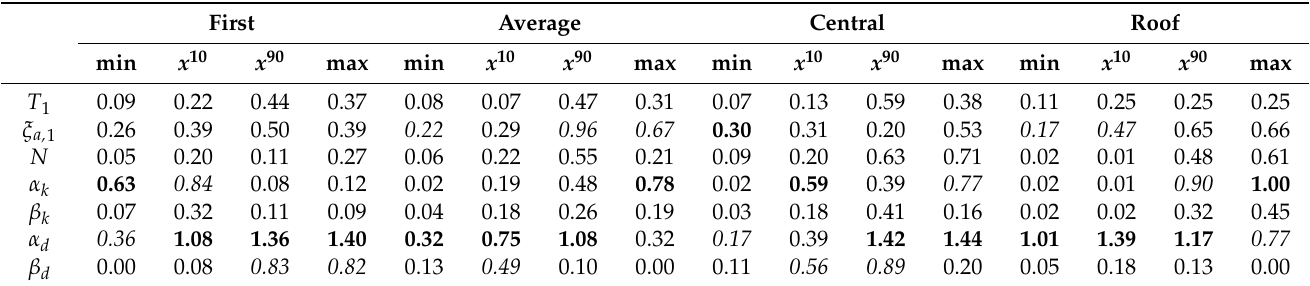
Table 4. Coefficient of variation c v for ∆ 1,error and case B0- ∞